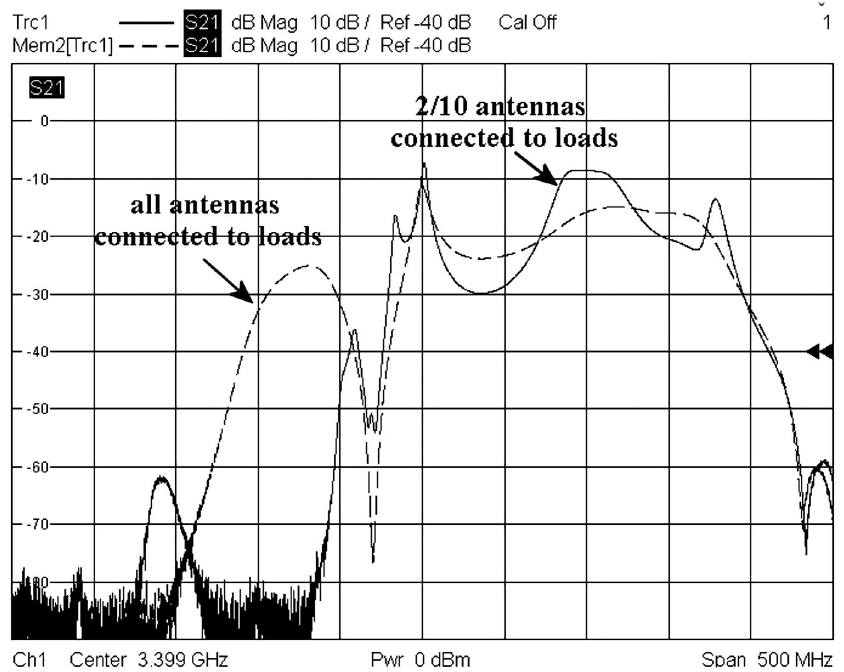
FIG. 18. Transmission coefficient between two